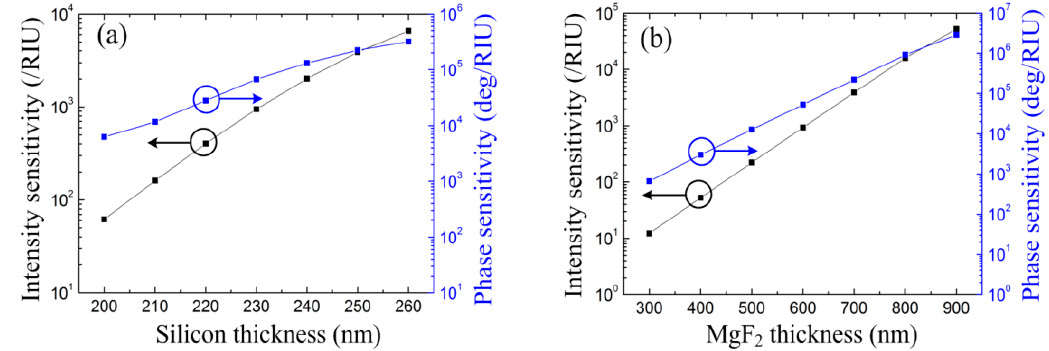
Figure 6. Sensing performance versus ( a ) silicon layer thickness with MgF 2 thickness fixed to be 700 nm, and ( b ) MgF 2 layer thickness with silicon thickness fixed to be 250 nm.